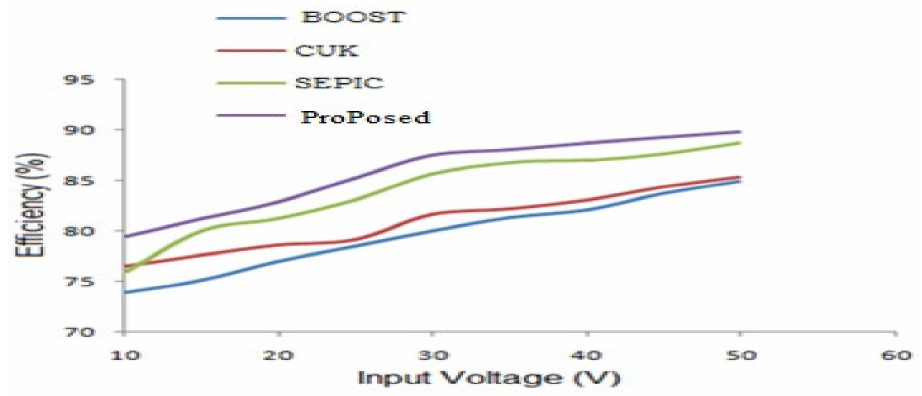
Figure 12. Efficiency versus input voltage.